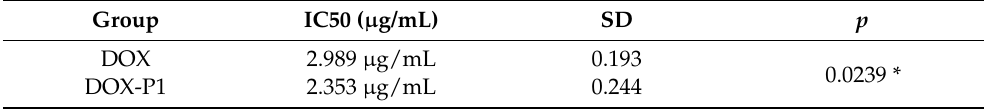
Table 3. IC50 of DOX and DOX-P1 (n =